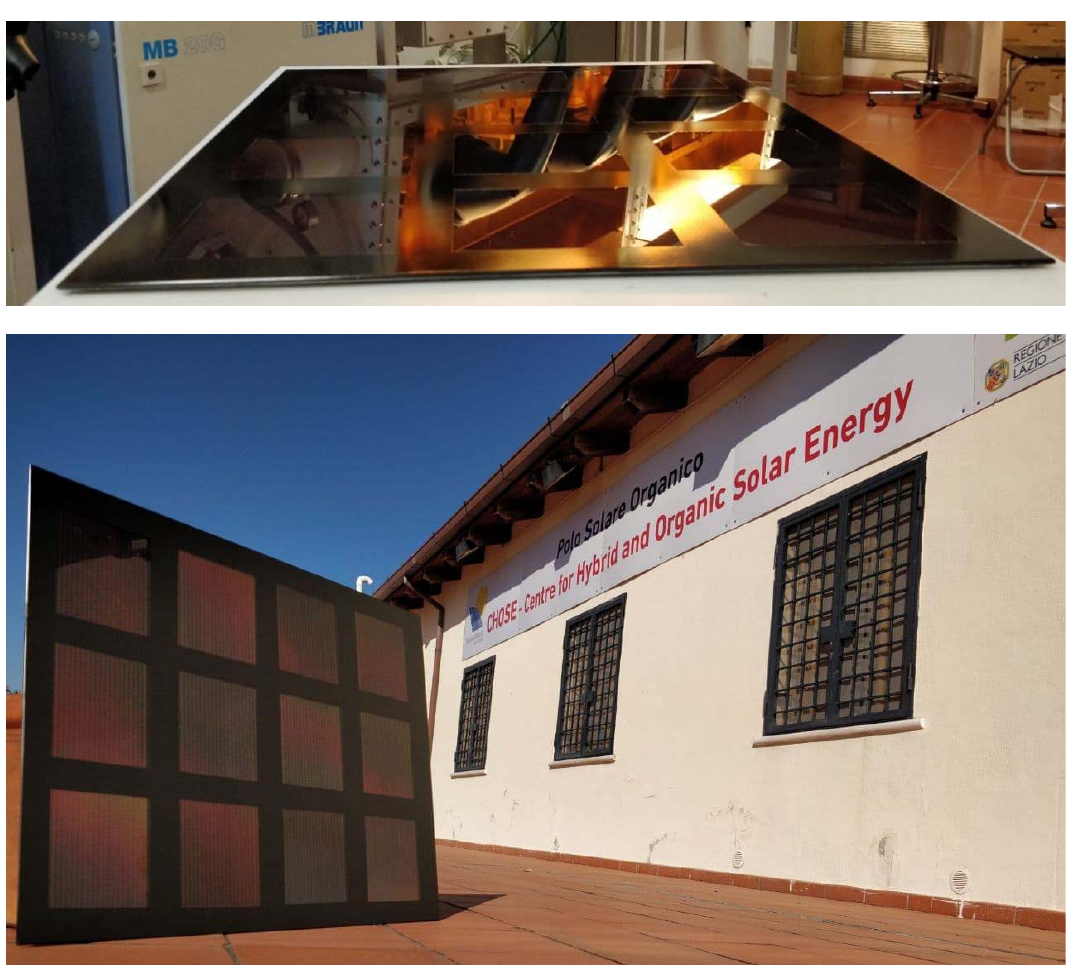
Figure 5. Picture of the panel fabricated inside the laboratory (on top ) and outside (at the bottom ).